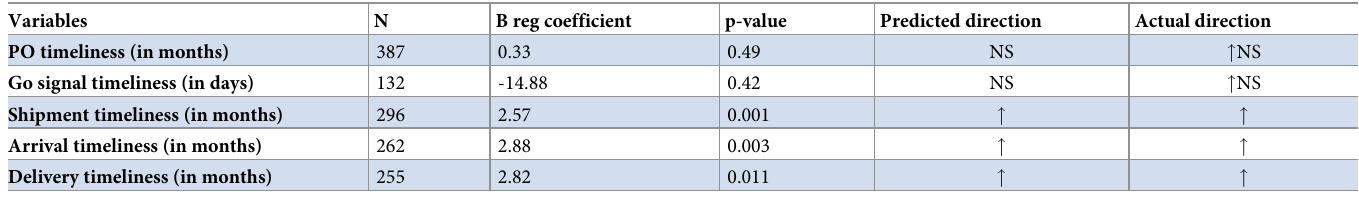
performance. Table 4. Regression results showing the relationship between implementation of publicly accessible country-level data through NTDeliver and NTD supply chain key performance indicators. Variables